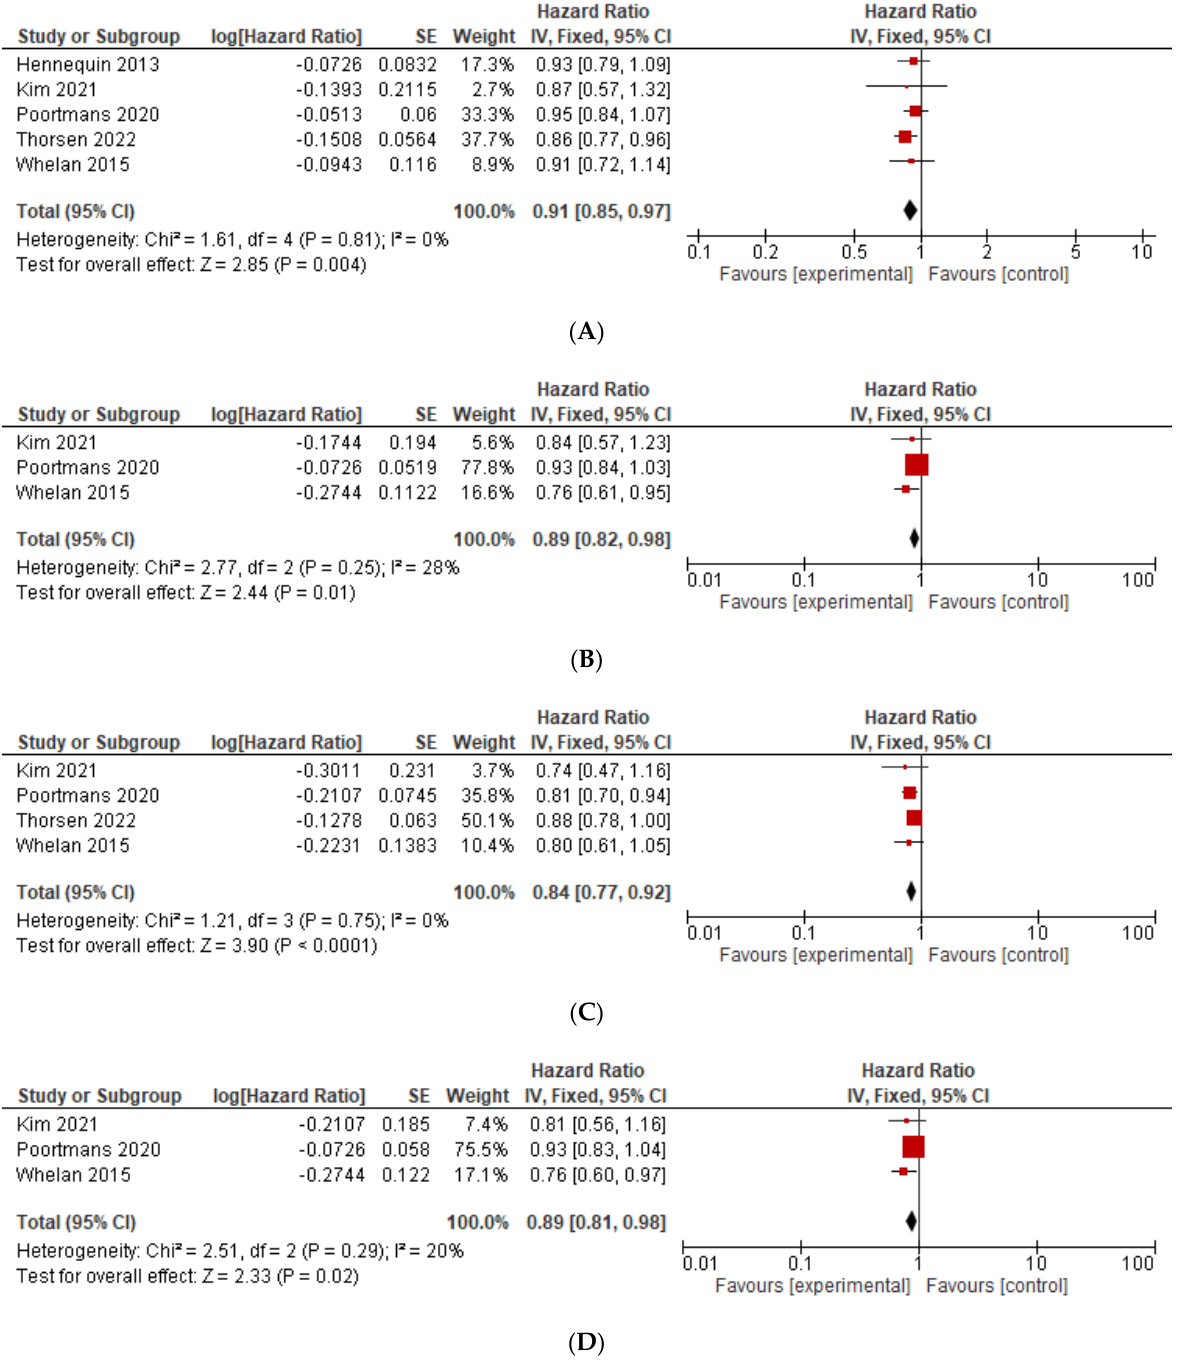
Figure 2. Forest plots for the efficacy, hazard ratio for: ( A ) OS; ( B ) DFS; ( C ) BCSS; ( D ) DMFS. The weight of each trial in the meta-analysis is represented by the size of the squares. The estimated pooled effect is represented by a diamond shape. p values are two-sided. References: Hennequin